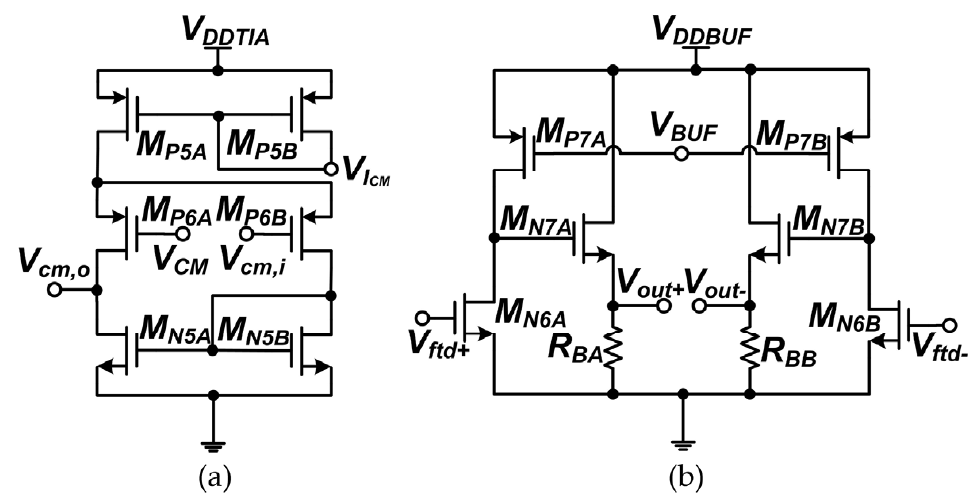
Figure 4. ( a ) Transistor-level schematic of the CMFB circuit and ( b ) buffer stage. The buffer after the mid-stage in Figure 4b has a common-source 𝑀 that off- (cid:3015)(cid:2874)(cid:3002)|(cid:3015)(cid:2874)(cid:3003) sets the gain loss of the common-drain 𝑀 , hence making it gain neutral. Its inputs (cid:3015)(cid:2875)(cid:3002)|(cid:3015)(cid:2875)(cid:3003) are at 𝑉 and outputs are at 𝑉 . (cid:3033)(cid:3047)(cid:3031)(cid:2878)|(cid:2879) (cid:3042)(cid:3048)(cid:3047)(cid:2878)|(cid:2879)